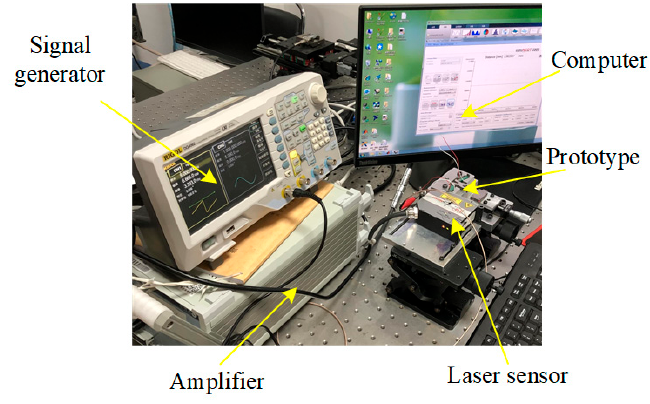
Figure 5. The experimental system.